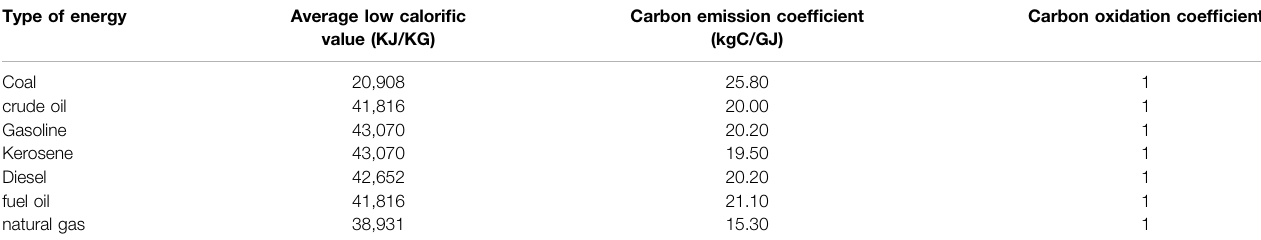
TABLE 1 | Carbon emission calculation factor.